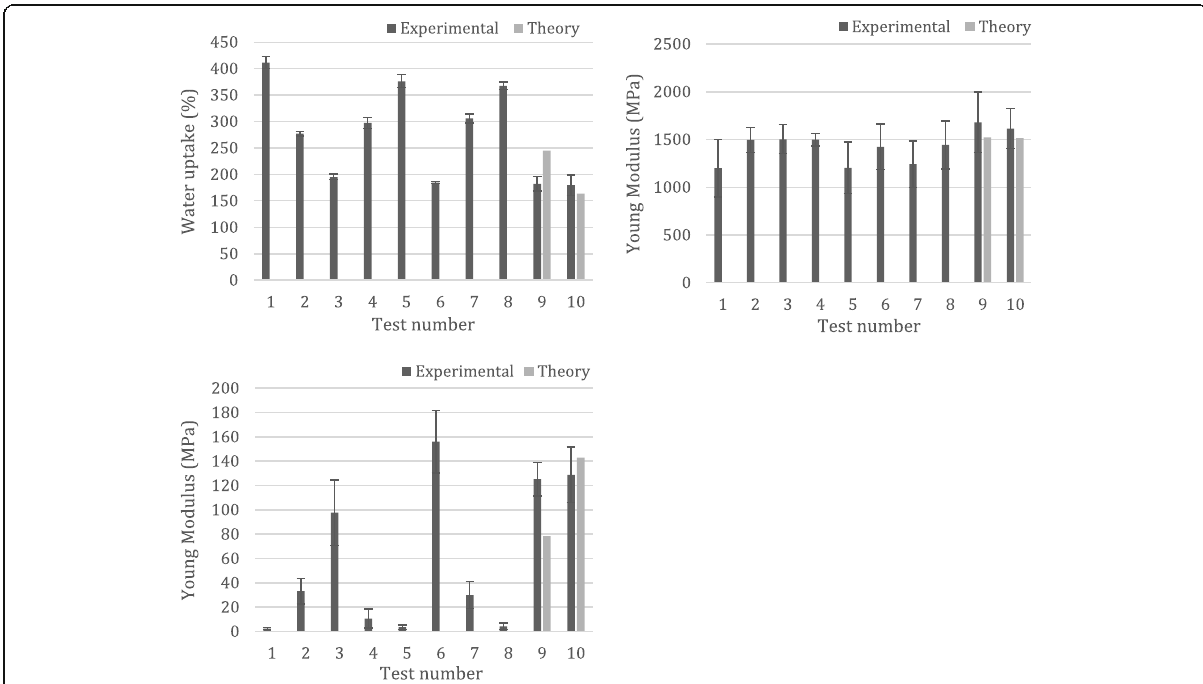
Fig. 4 Water uptake (top left), initial mechanical properties (top right) and mechanical properties after 30h immersion (bottom left) of MPP ’ s depending on the process parameters